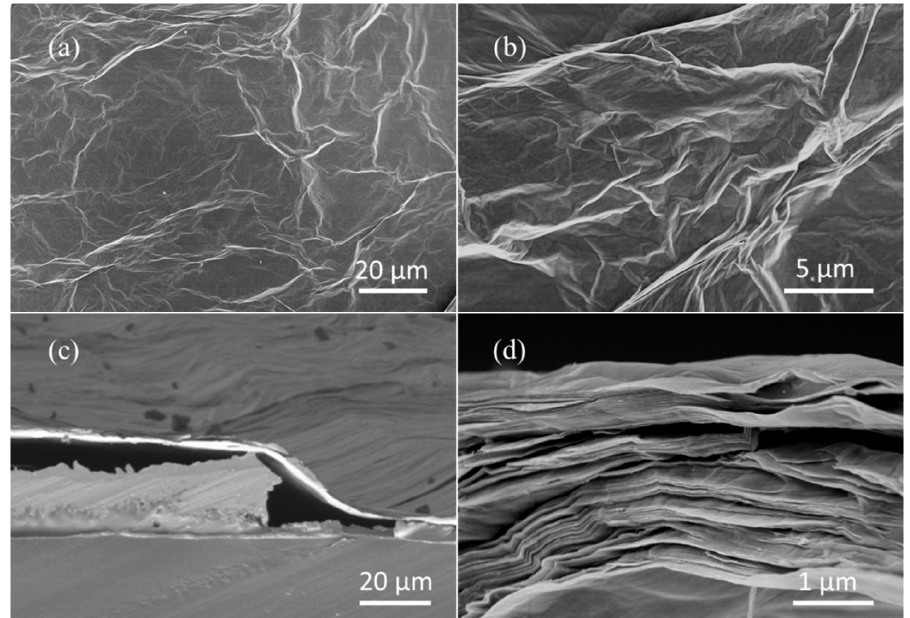
Figure 2. SEM micrographs of the sensitive films. ( a , b ) top-view surface micrographs; ( c , d ) cross section micrographs.